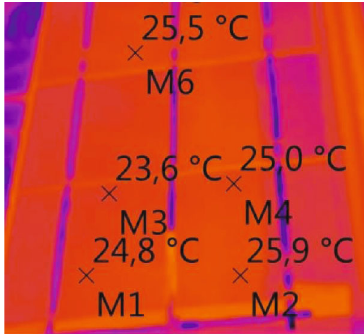
Figure 9: The temperature distribution